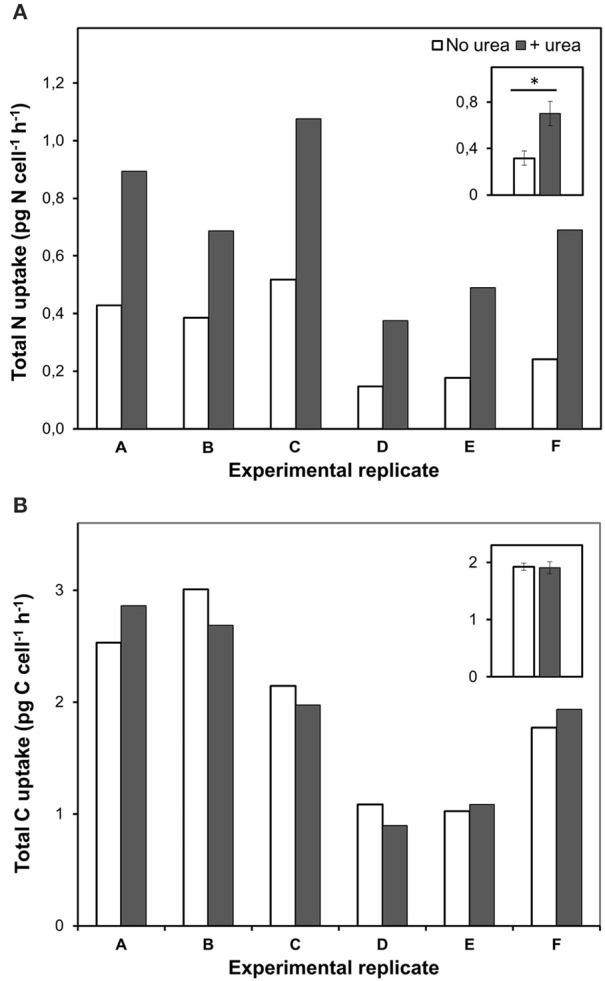
Total nitrogen and bicarbonate uptake by P. minimum in the absence of urea and following the addition of urea. Insets show averaged data for all experimental replicates, the values are means ± 1 SE. The asterisk indicates a significant difference between uptake rates. (A) Total nitrogen uptake. Total nitrogen uptake was significantly higher after urea addition (one-tailed Wilcoxon test, p < 0.05, n = 6). (B) Total carbon uptake. Total carbon uptake did not differ significantly in the absence and presence of urea (two-tailed Wilcoxon test, p = 1, n = 6).